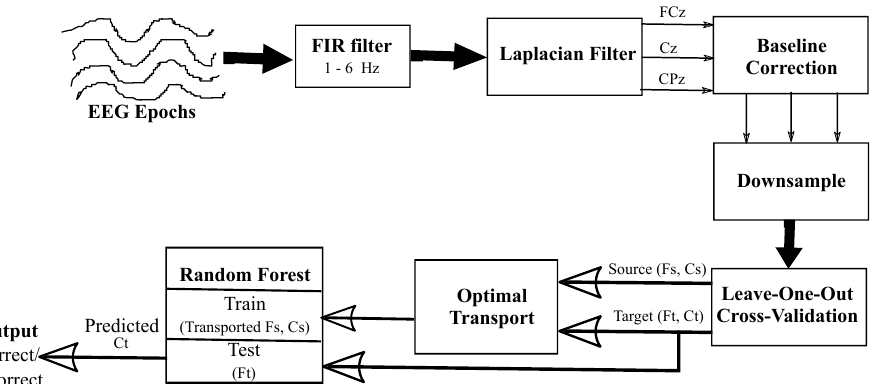
Figure 3. Block diagram representing the error detection pipeline, beginning from the processing of neural signals to the generation of the feature vectors, the transport of the source data to the target domain, and, finally, classification using random